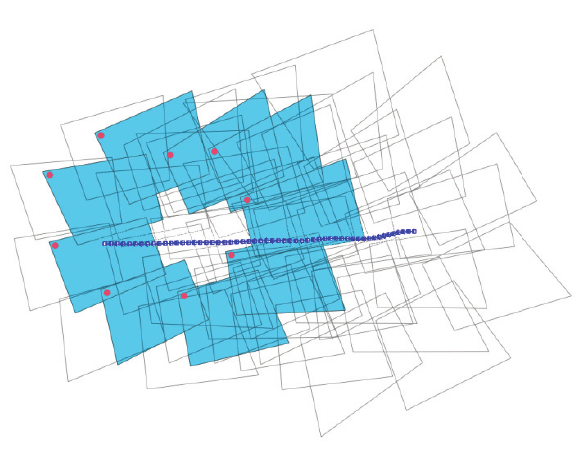
Figure 10. Footprints of a tumbling (wobbling) camera. Blue dots assign the flight path. Red dots mark upper right image corner, thus no rotation around optical axis.